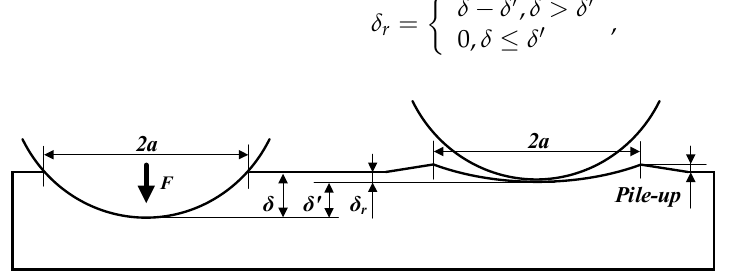
Figure 6. Surface profile of IS during loading and unloading.